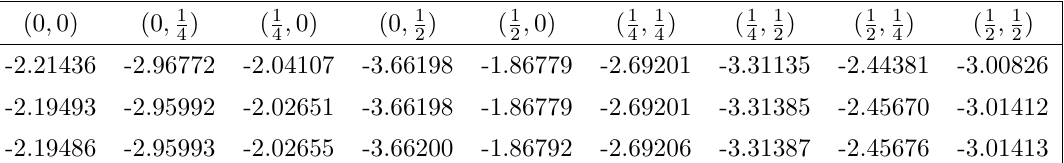
Table 1 . The Szegő-Akhiezer-Kac formula (D.3) for g = 2 and different values of the pair ( ‘, β ) . The entries in the first row are obtained by neglecting O (1 /g ) corrections on the right-hand side of (D.3), the entries in the second row take into account the O (1 /g 6 ) terms. The last row shows the results of numerical evaluation. For ‘ + β = 1 / 2 the entries in the first and second raws coincide in virtue of the first relation in